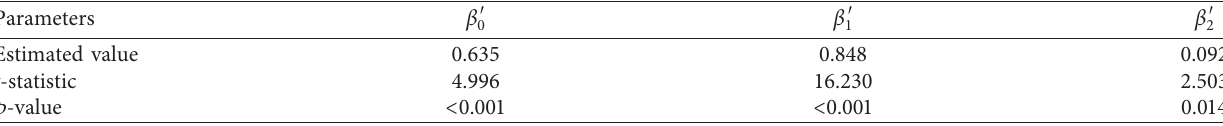
Figure 2: The effect of crowding level and boarding passenger volume on boarding time. (a) Relation between boarding passenger number and boarding time under given crowding level. (b) Relation between crowding level and boarding time under given boarding passengers. Table 4: Parameter estimations of alighting time model based on